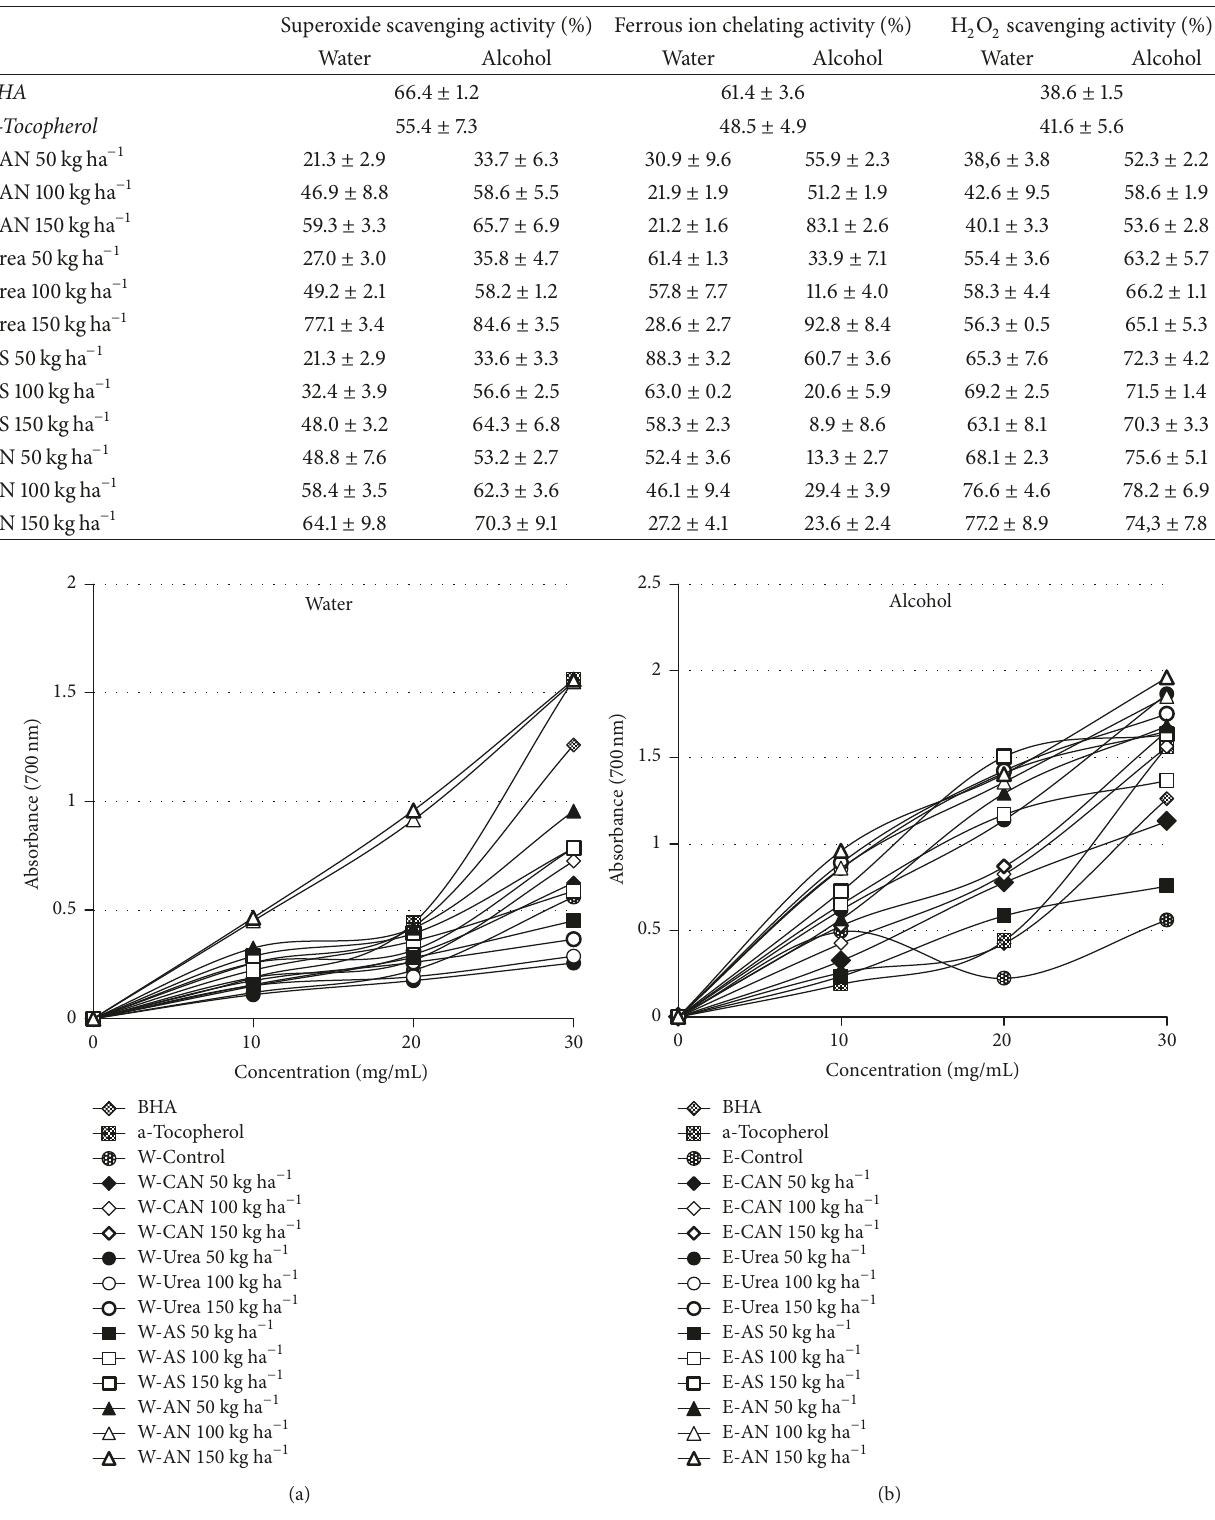
Figure 1: The Fe 3+ -Fe 2+ reducing activity of different concentrations (10–30 𝜇 g/mL) of water extracts, alcohol extracts, 𝛼 -tocopherol, and